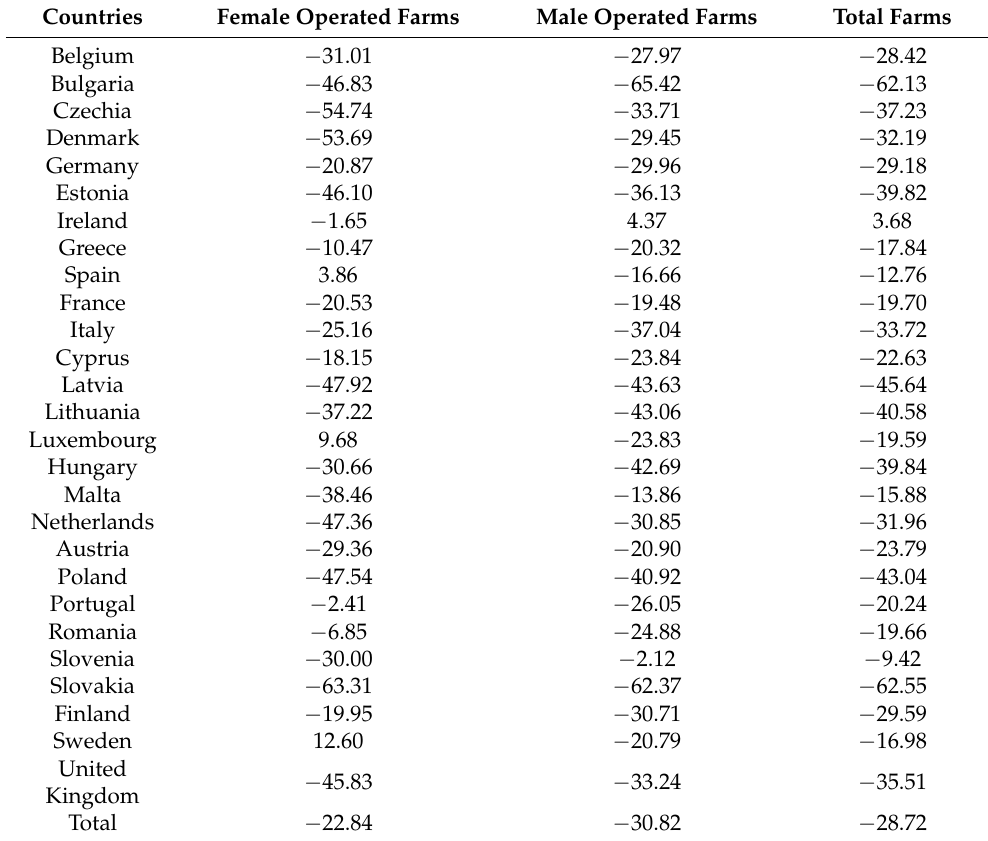
Table 1. Female- vs. male-operated farms in the EU countries, var % 2016–2005. Countries Female Operated Farms Male Operated Farms Total Farms Belgium − 31.01 − 27.97 − 28.42 − 46.83 −